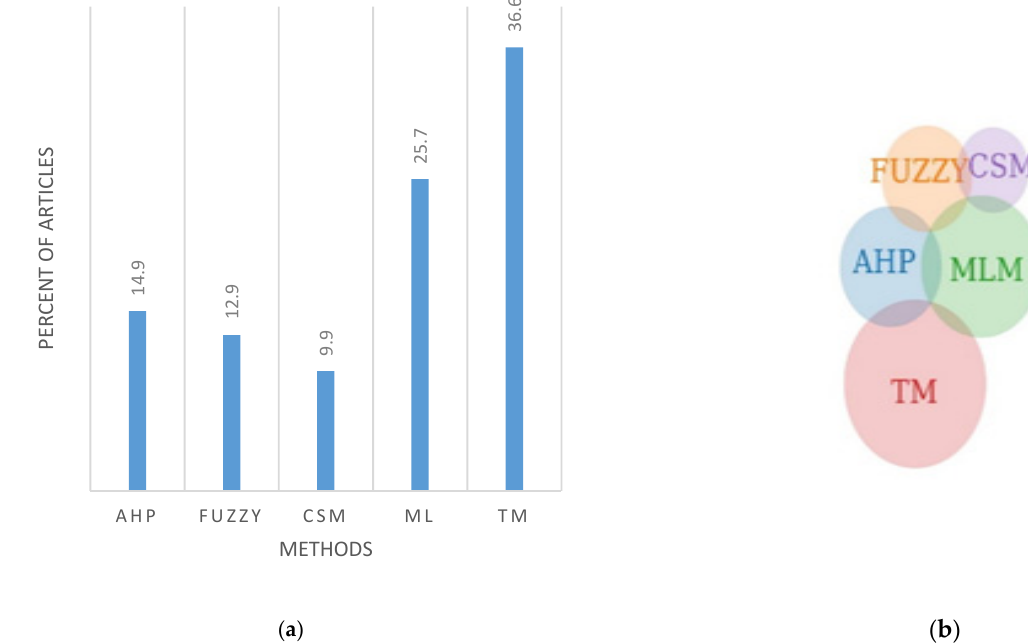
Figure 1. ( a ) The percentage distribution of land suitability methods published from 1993 to 2019. (Analytical hierarchy process (AHP), Crop Simulation Models (CSM), Machine learning method (ML/MLM), traditional method (TM)). ( b ) The hybrid land evaluation systems, the combination was selected from land suitability methods published from 1993 to 2019. (Analytical hierarchy process (AHP), crop simulation models (CSM), machine learning method (MLM), traditional method (TM)).